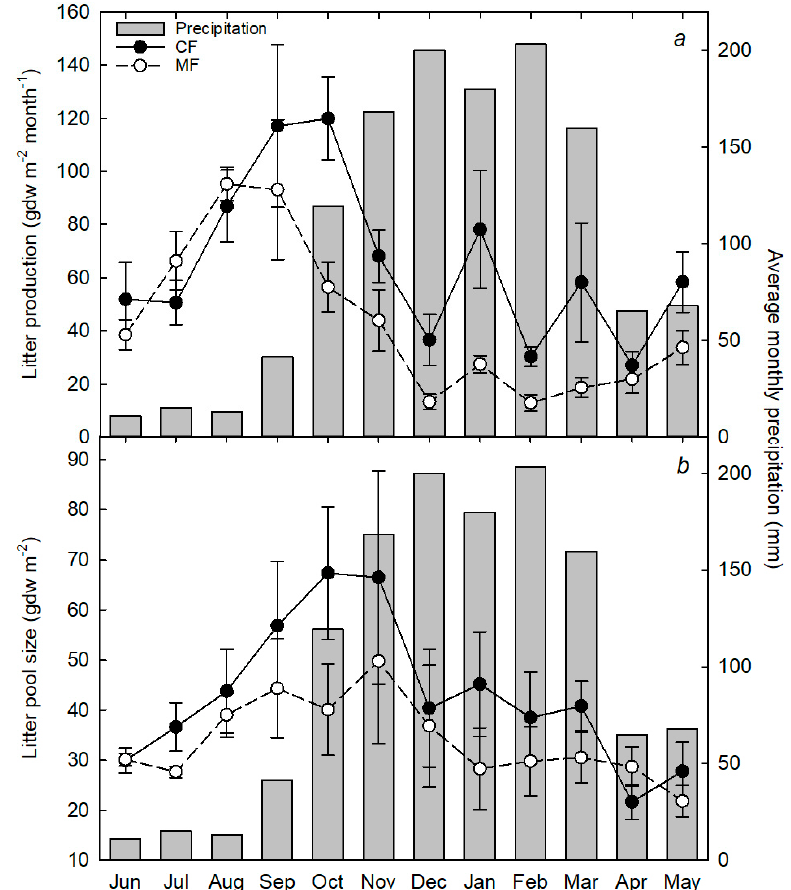
Figure 1. Mean ( ± 95% confidence interval; n = 6) monthly rates of litter production ( a ) and litter pool size ( b ) presented as dry mass per unit area (gdw m − 2 ) for the seasonally flooded cerrado forest (CF: closed symbols; solid lines) and the upland mixed forest (MF: open symbols; dashed lines) during the 2014–19 study period. The solid bars in both panels are the average monthly rainfall for the same period.